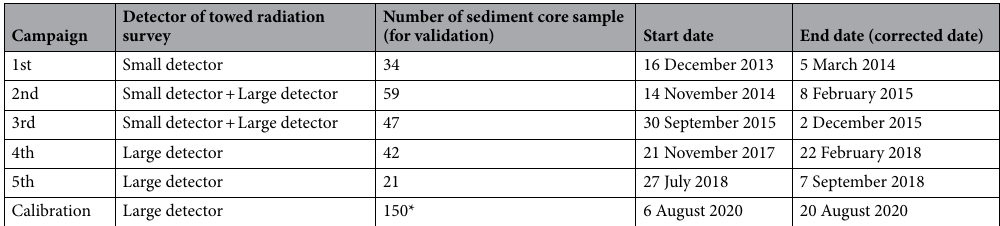
Table 1. Achievements of the survey campaign. *Grab